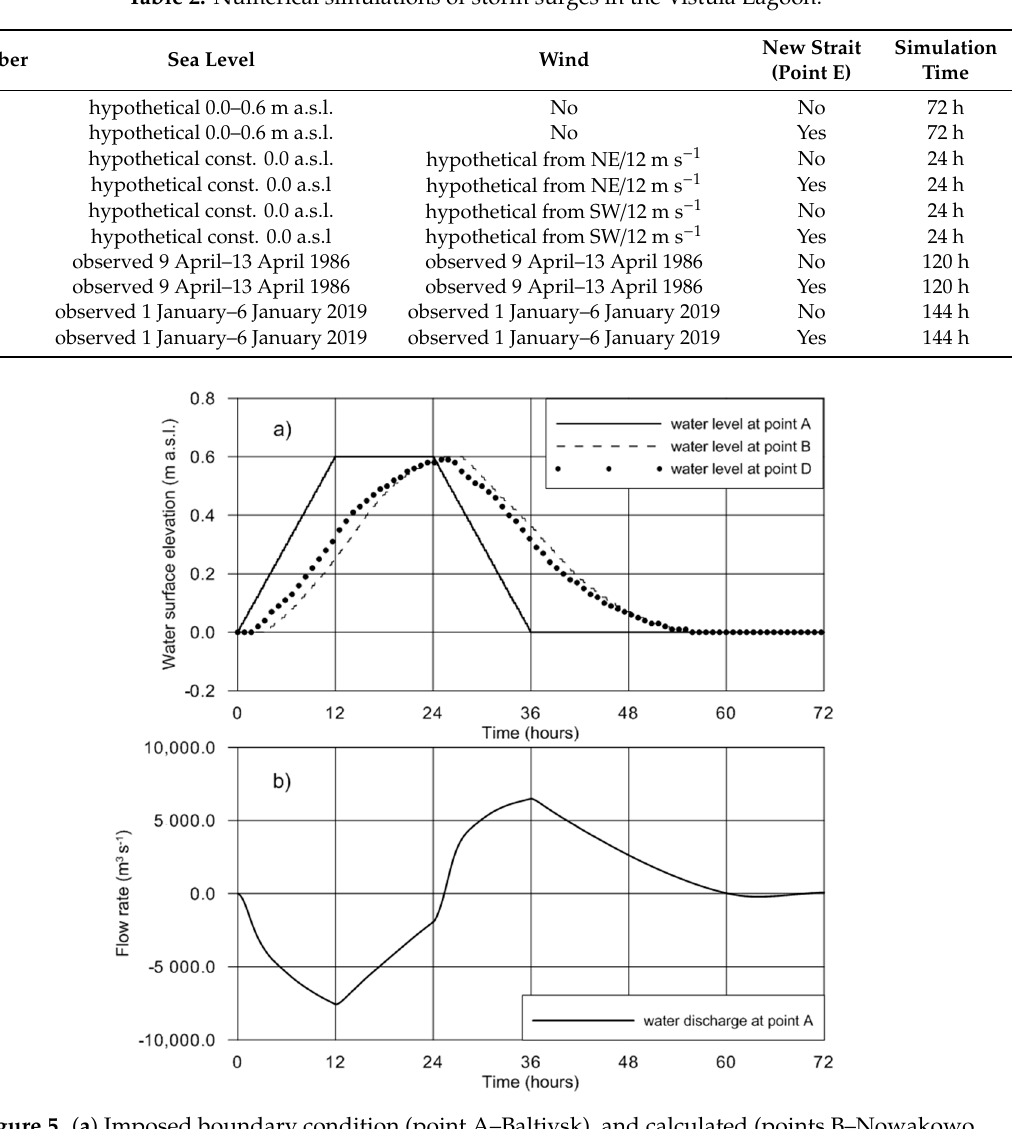
Table 2. Numerical simulations of storm surges in the Vistula